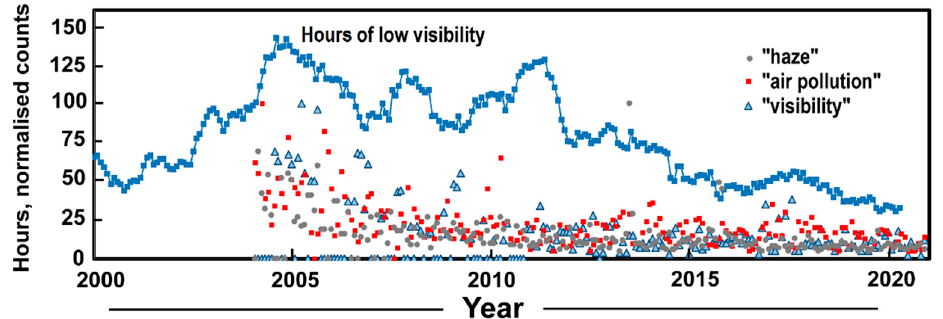
Figure 4. Hours of low visibility each month at the HKO as the annual running mean, and the fre- quency of search queries from Hong Kong in Google Trends 2004–2020 for “visibility”, “air pollu- tion”, and “haze”.